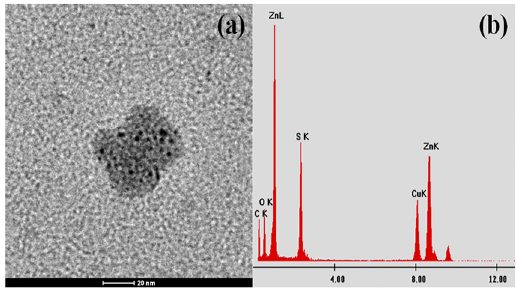
Figure 3. a)TEM micrograph and b) EDS result for ZnS